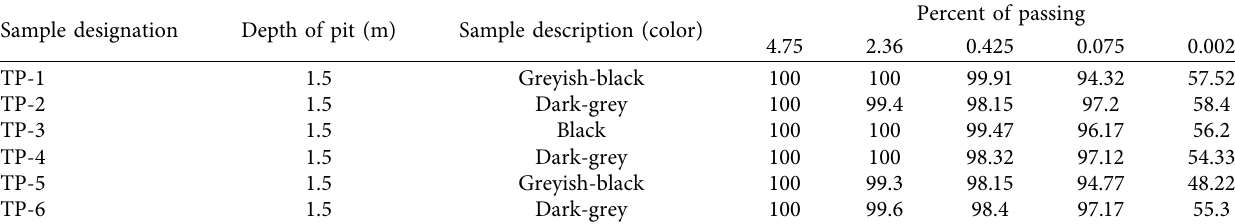
Table 2: Characterization of expansive soil and particle size distribution.